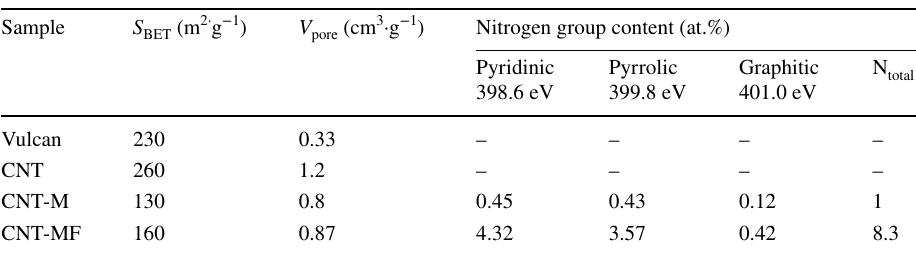
nitrogen adsorption and XPS data: specific surface area ( S BET ), pore volume ( V pore ) and atomic content of nitrogen